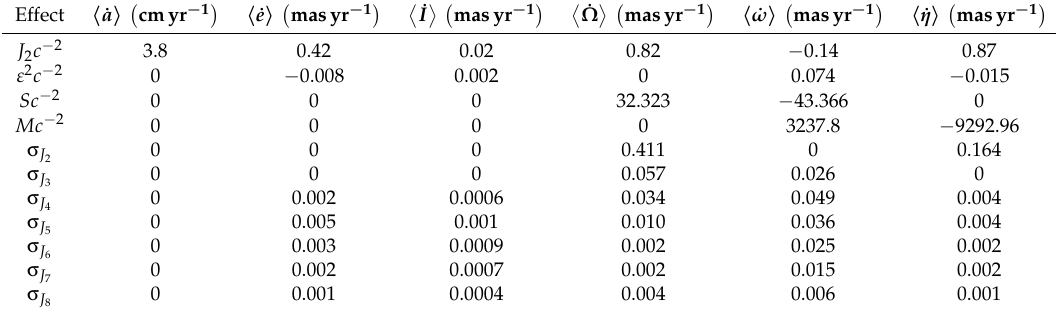
(cid:10) ˙ (cid:11) (cid:10) ˙ Ω (cid:11) I , , (cid:104) ˙ ω (cid:105) , (cid:104) ˙ η (cid:105) .